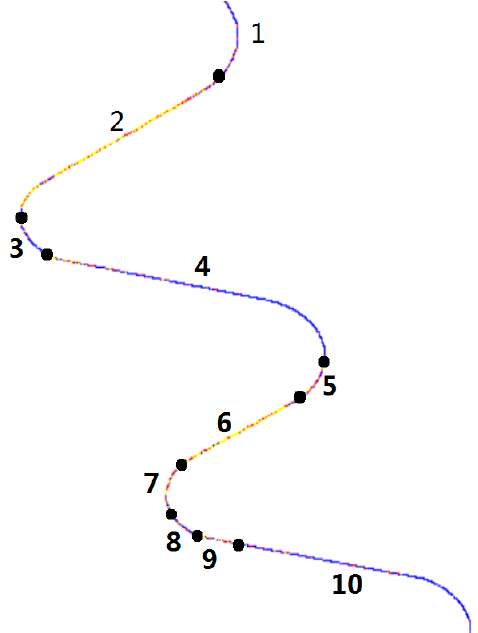
Figure 5. Defect prediction with respect to the ideal profile as produced by the network. Table 5. Comparison of results between the current method (CMM) and the proposed deep neural network for defect